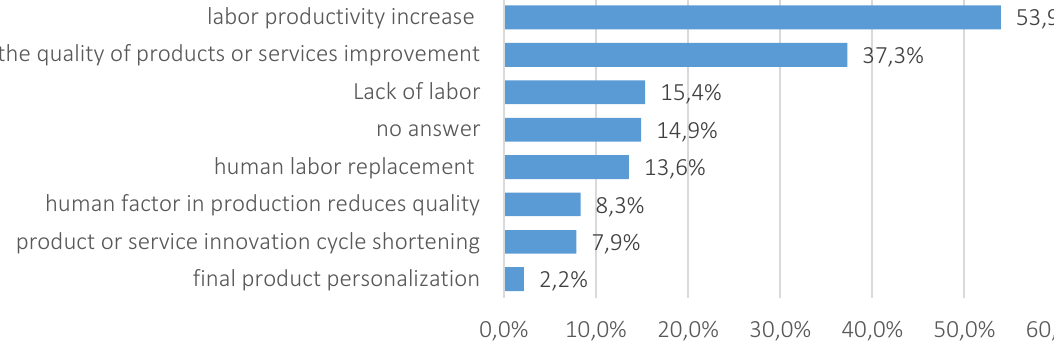
Figure 5. The main reason for the Industry 4.0 implementation in Slovak